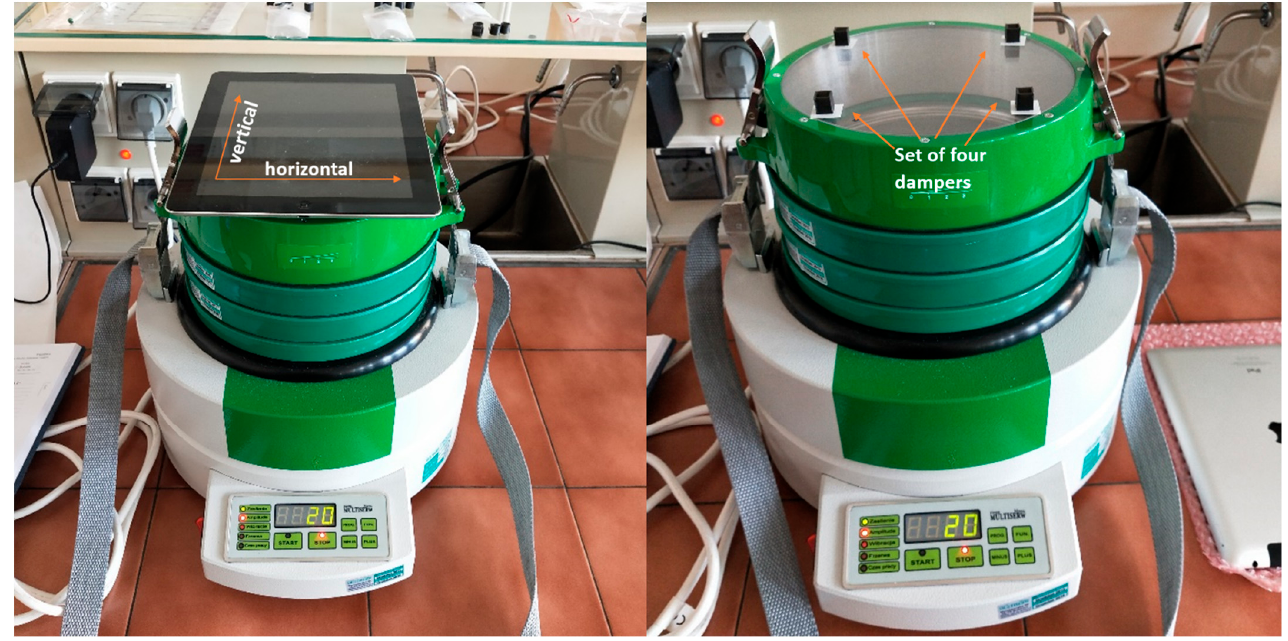
Figure 5. Damping vibration test setup: left hand side, directions of acceleration measurement; right hand side, set of four dampers placed on the top of mechanical sieve shaker.